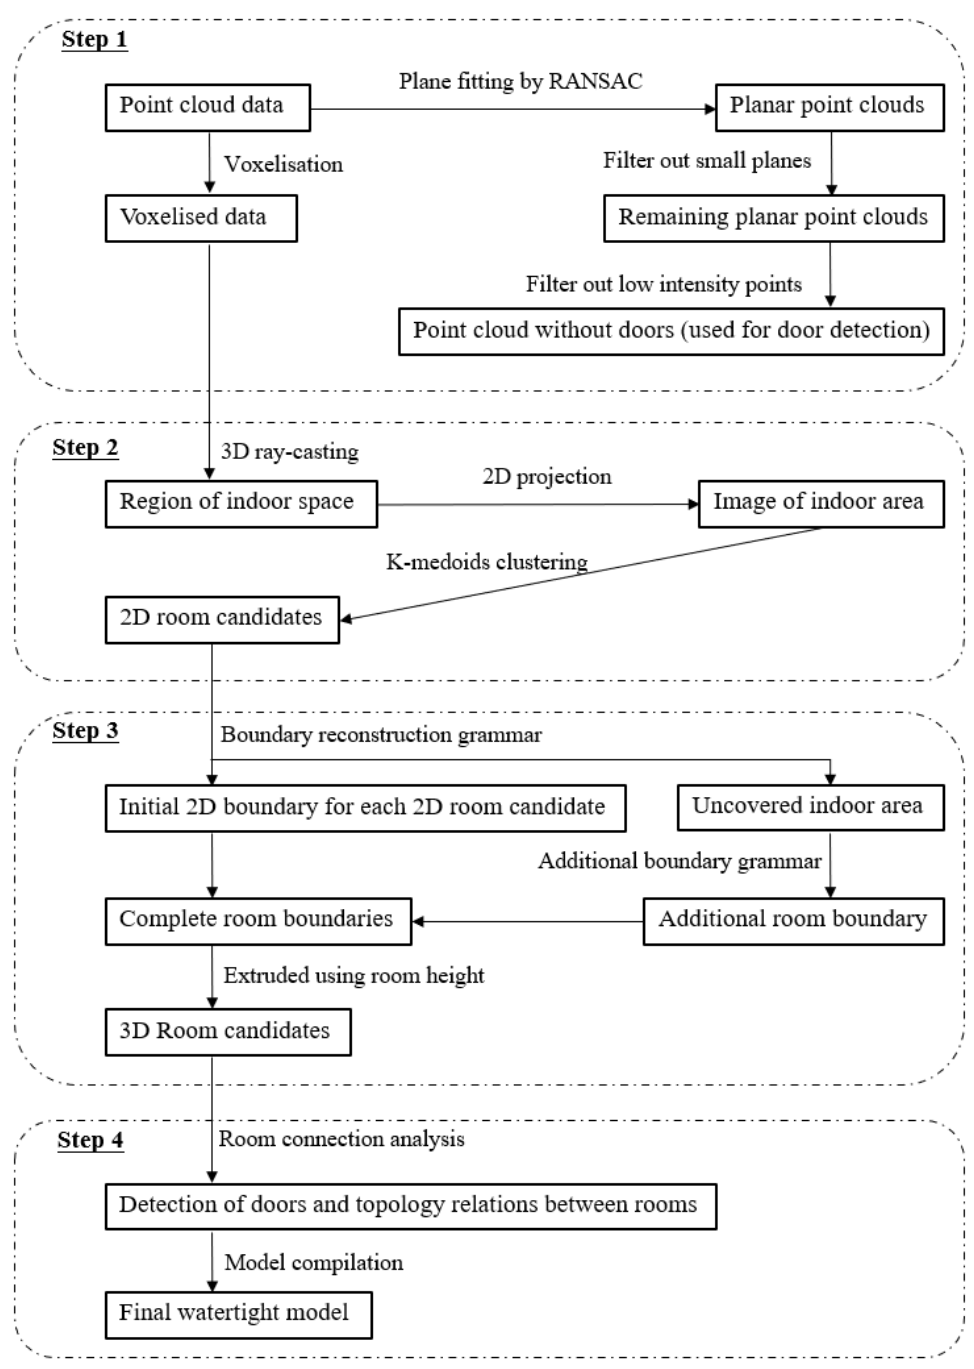
Figure 2. Flowchart of the approach proposed: Pre-process, segmentation of 2D room candidates, reconstruction for 3D room candidates, connection analysis of 3D room candidates and final model compilation.